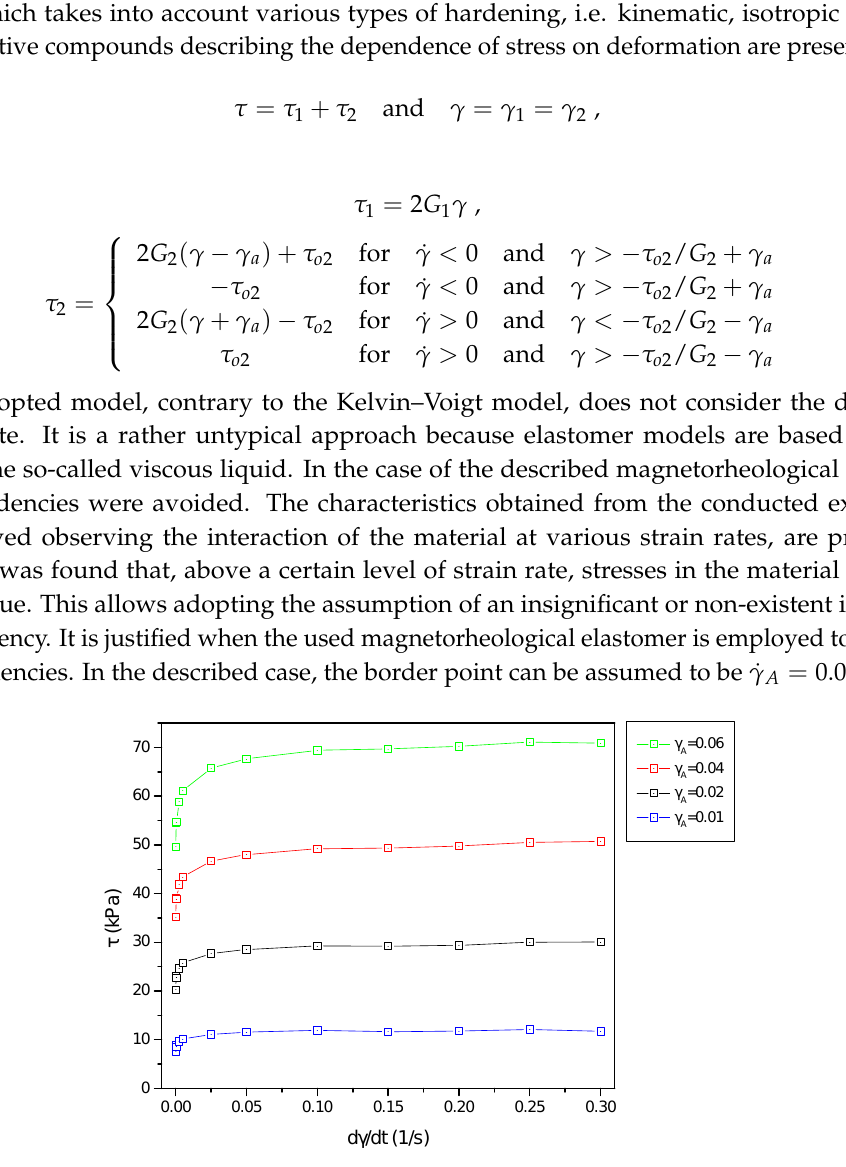
Figure 6. Dependence of stress inside magnetorheological elastomer on strain rate for various strain